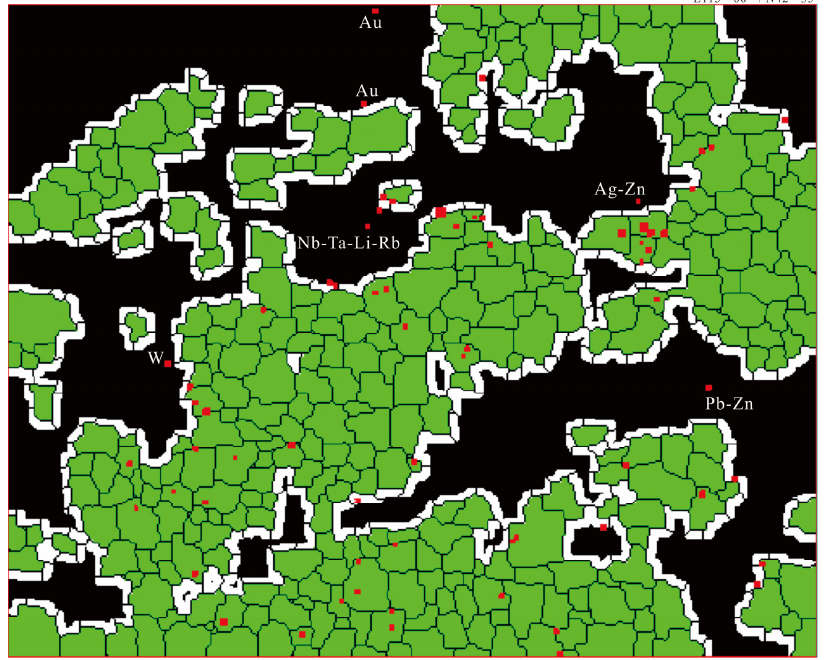
Figure 15. The buffered anomalous regions (green colored patches edged with white) with all the known ore spots overlaid on it. Note that the anomalous regions are generated by using the geo- chemical dataset consisting of the major rock-forming elements as input to OGE. We set the binari- zation threshold as the 50% quantile: 0.66982. Other legends in this figure are consistent with those in Figure 11 if not specified.